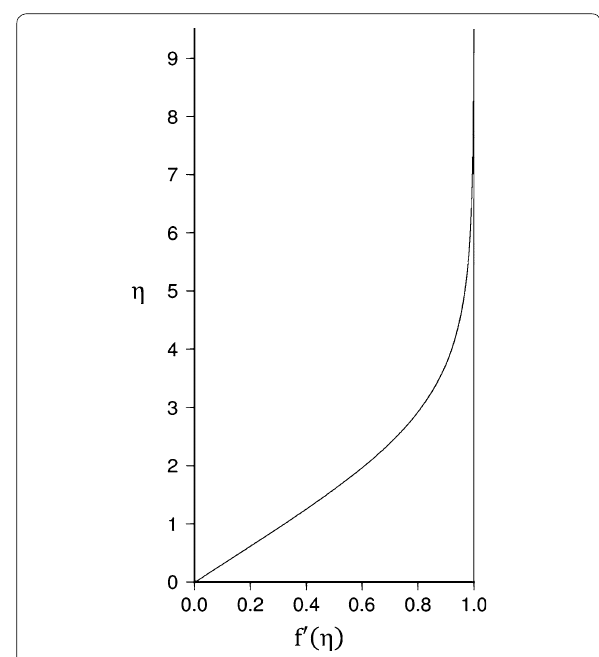
Fig. 2 Flow rate, f ′ (η) , with distance, η , produced by the model of Ishak and Bachok (2009) for n 0.7. f ′ (η) is the x ‑component of the = flow rate in η , and η is the dimensionless distance perpendicular to the